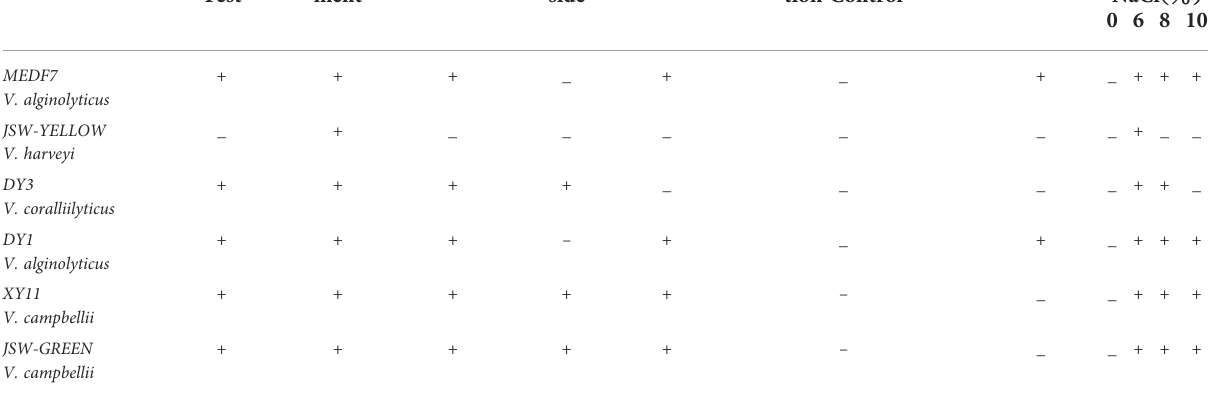
TABLE 2 The biochemical pro fi le of six strain of Vibrio